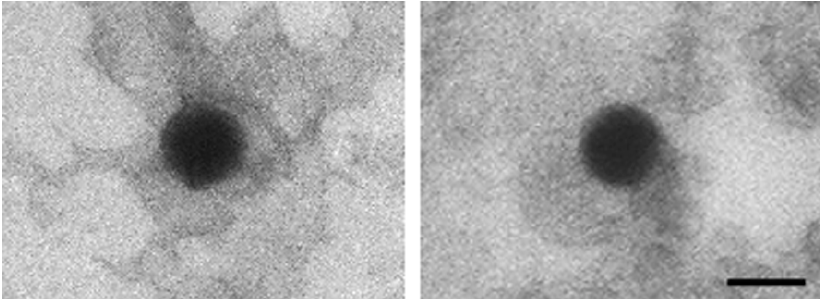
Figure 1. Representative TEM photomicrographs showing nanoparticles from the diluted concen- trated vaccine. Scale bar: 100 nm.